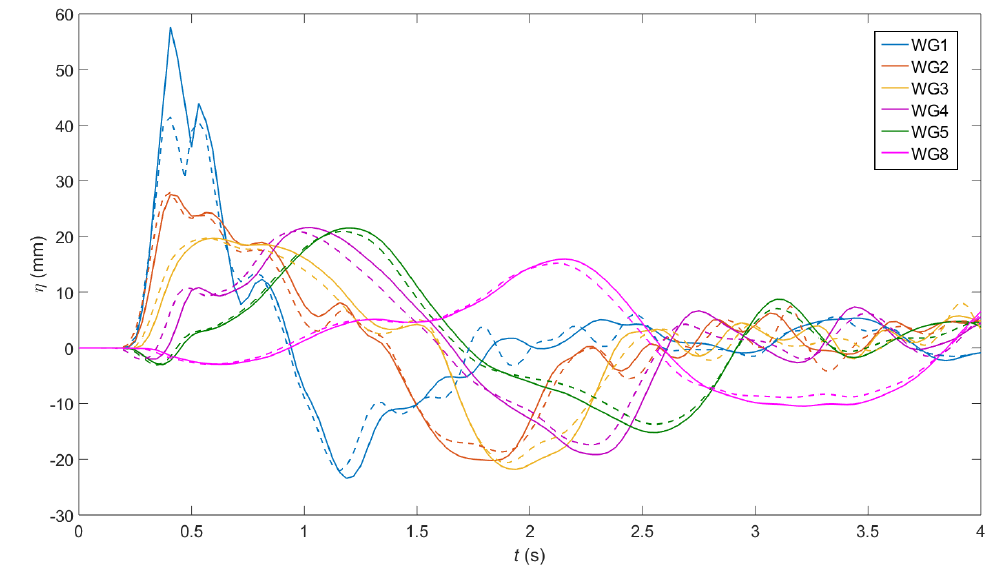
Figure 14. Surface elevation time histories for an inclined uplift of 60 mm and landslide model ML3 (solid lines), or ML3B (dashed lines) in 370 mm water